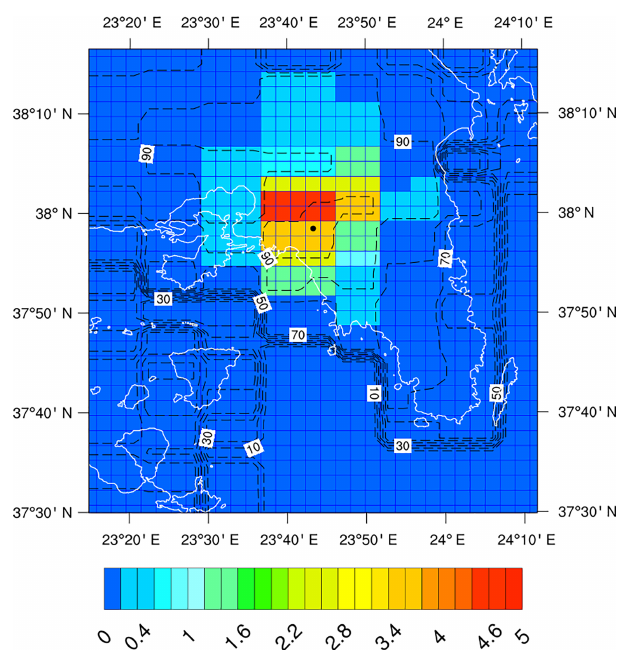
Figure 2. RWB aerosol emission rates (kgh − 1 km − 2 ; color con- tours) and their fraction of the total aerosol emissions (isolines in %) for a night hour of a weekday (Tuesday, 21:00UTC), as retrieved from the revised emission data (TNO-MACC_II). It is noted that the spatial resolution of the emissions (0 . 125 ◦ × 0 . 0625 ◦ ) is coarser than that of the model configuration (0 . 025 ◦ × 0 . 025 ◦ ; embedded grid). The city center of Athens is shown with the black